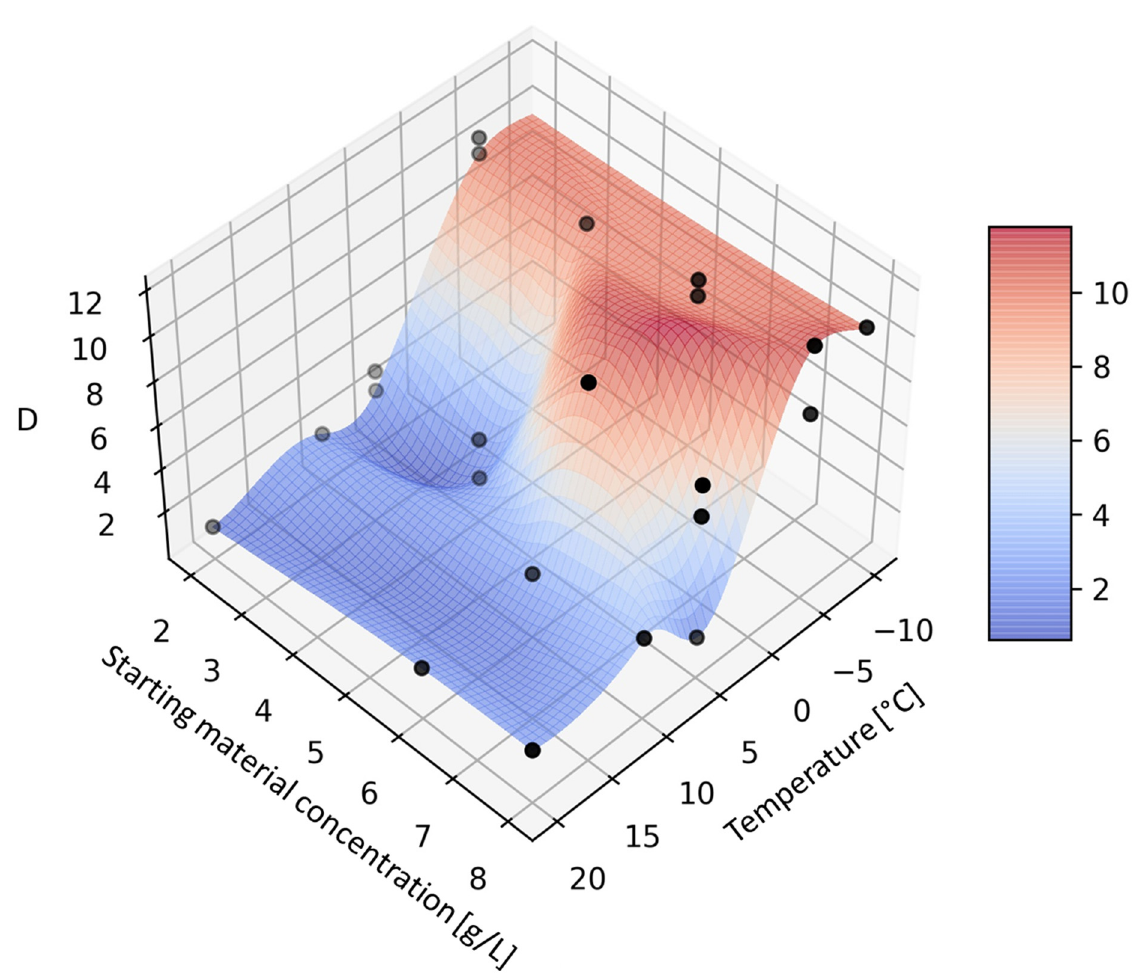
Figure 3. Graph of diastereoselectivity (D) as a function of temperature and concentration of silybin diastereomeric mix- ture.